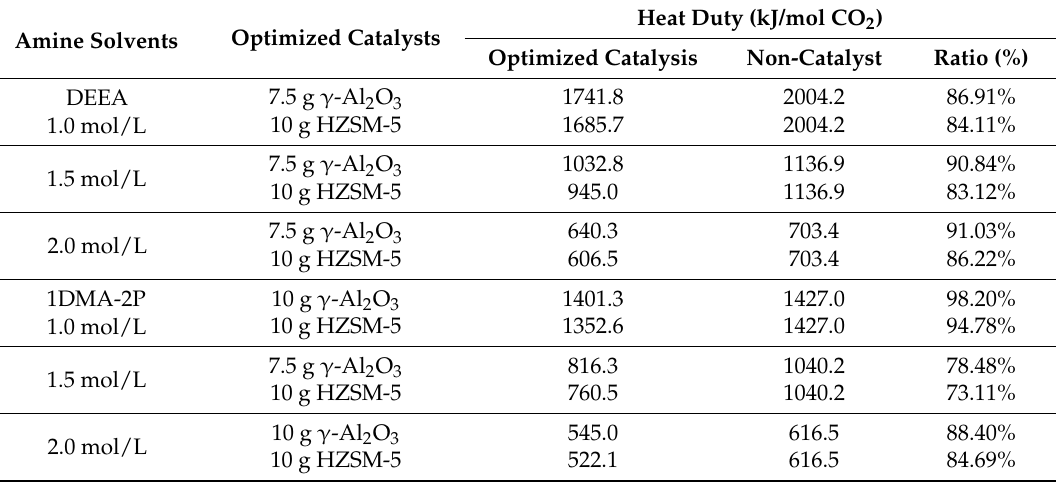
Table 3. The relative heat duty (%) of different amine solvents under optimized catalysis at 363 K and 1 atm. Amine